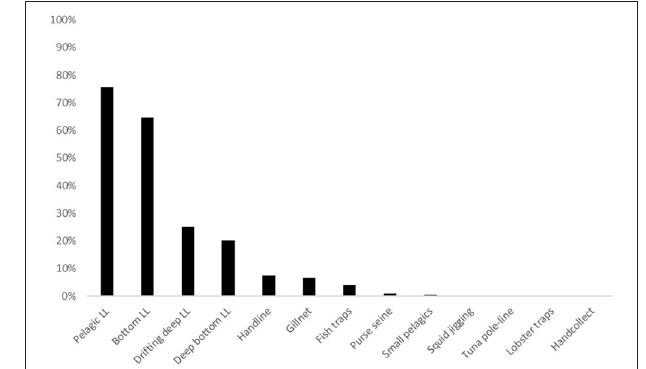
FIGURE 5 | Frequency of elasmobranch landings (% of total landings) per métier.